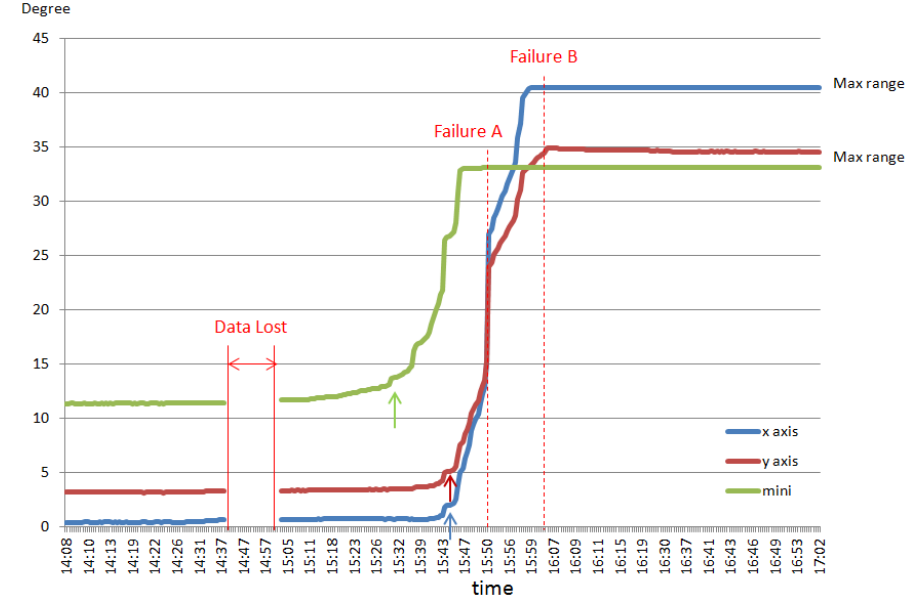
Figure 11. Monitoring data from the two-axis large and one-axis mini inclinometers.